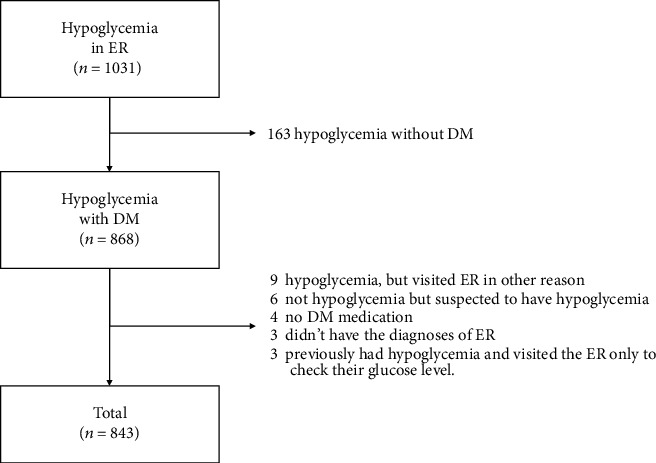
Flowchart of patient enrollment and status (n = 843). DM: diabetes mellitus; ER: emergency room.